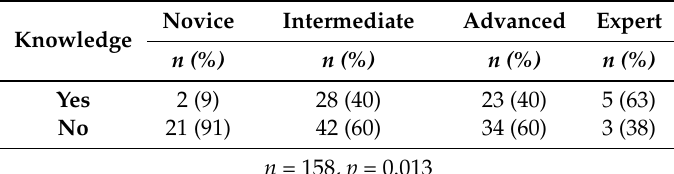
Table 9. Detection accuracy by knowledge level (greip